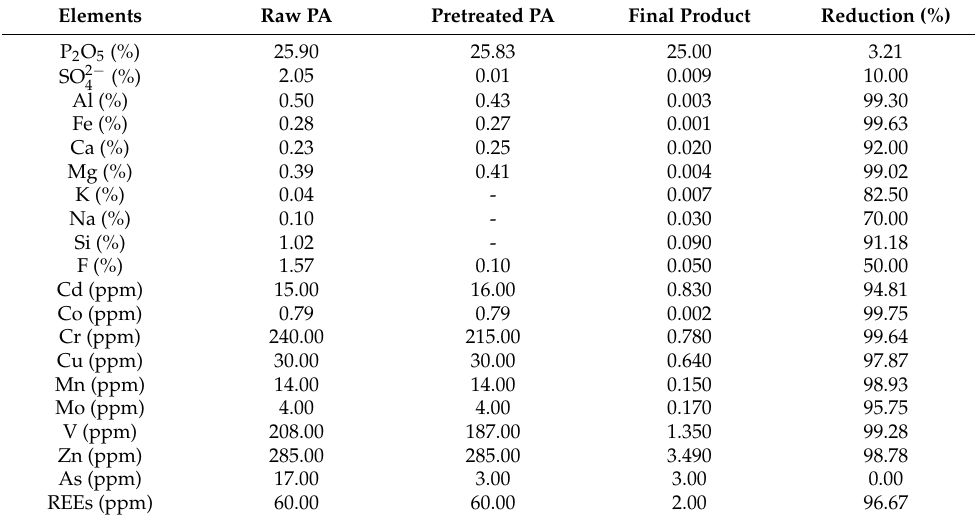
Table 2. Elemental content of raw PA, pretreated PA and nanofiltrated PA at 60 ◦ C and 600 L/h flow rate. Elements Raw PA Pretreated